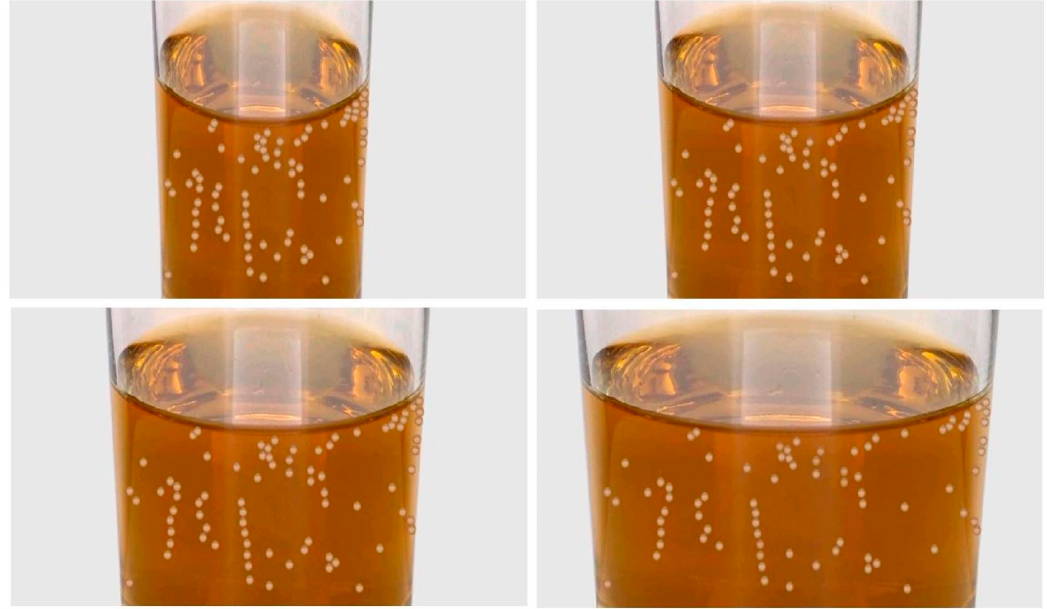
Figure 3. Pictures of the big bubbles visual stimuli used in Experiment 2, varying in width of the glass, for the brown liquid. See the Supplementary Materials Tables S1–S5 for the other sets of visual stimuli that were used.